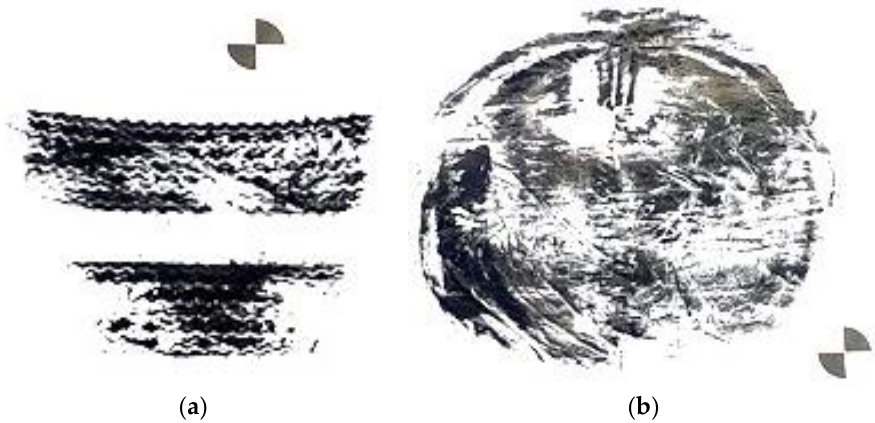
Figure 13. Experimental measurement of the reference impact area A corresponding to ( a ) TT or ( b ) SB impactors (acquisition for E imp = 900